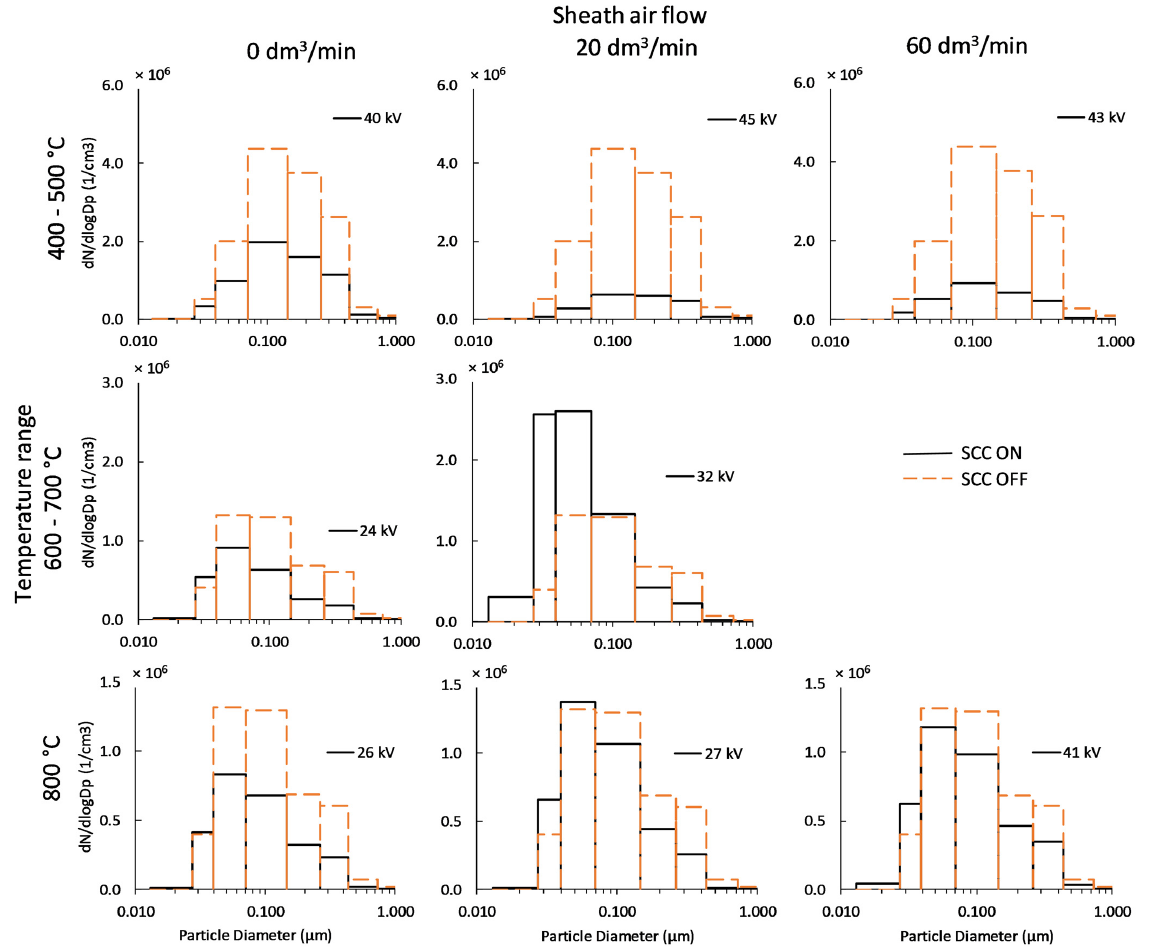
Figure 6. Particle number size distributions measured by an electrical low-pressure impactor (ELPI) upstream of the heat exchangers at different temperatures surrounding the shielded corona charger (SCC) and with different sheath air flow rates.